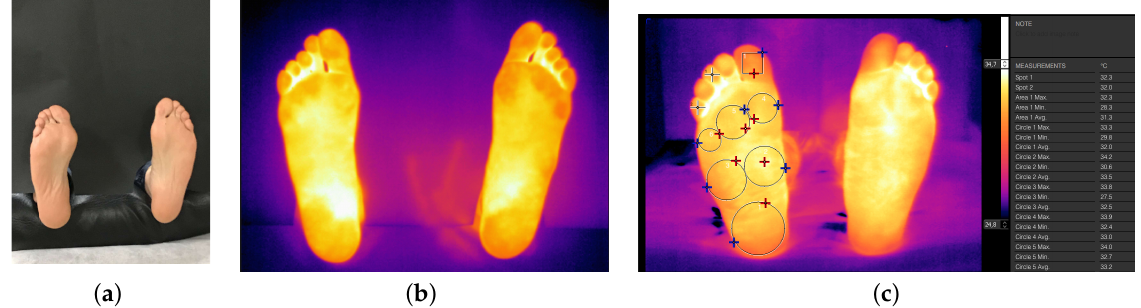
Figure 1. ( a ) Feet covered with a black cardboard prior to the thermal picture, ( b ) Thermographic picture obtained and ( c ) Taking data temperatures of the nine regions of the foot (with Spanish format, where the comma indicates decimal